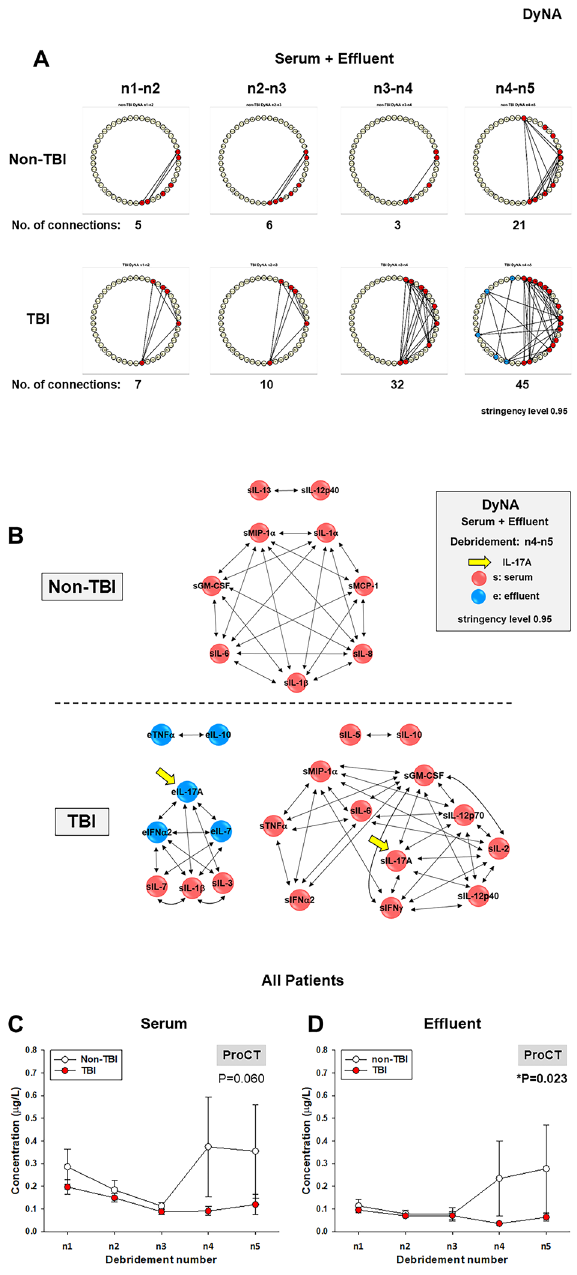
Figure 5. IL-17A connectivity in inflammatory networks and levels of ProCT in serum and wound effluent samples of TBI vs. non-TBI trauma patients. Circulating inflammatory mediators in serum and wound effluent samples combined from 59 TBI and 81 non-TBI patients were measured, and DyNA (stringency level = 0.95) was performed during each of four debridement intervals (n1-n2, n2-n3, n3-n4, n4-n5) using MATLAB® software as described in “Materials and methods” and Fig. 2 . ( A ) Shows an overview of all the networks and mediator connections in both patient subgroups (the closed red and blue circles represent mediators with at least one connection to another mediator in serum and wound effluent, respectively, while open circles represent mediators that had no connections to other mediators as determined by DyNA) The total number of mediator connections for each debridement interval is shown below each network. ( B ) Shows the network complexity for each patient subgroup during the n4-n5 debridement interval calculated as described in “Materials and methods”. ( C , D ) Show levels of ProCT in serum and wound effluent samples from TBI and non-TBI trauma patients as a function of debridement number (*P < 0.05, analyzed by Two-Way